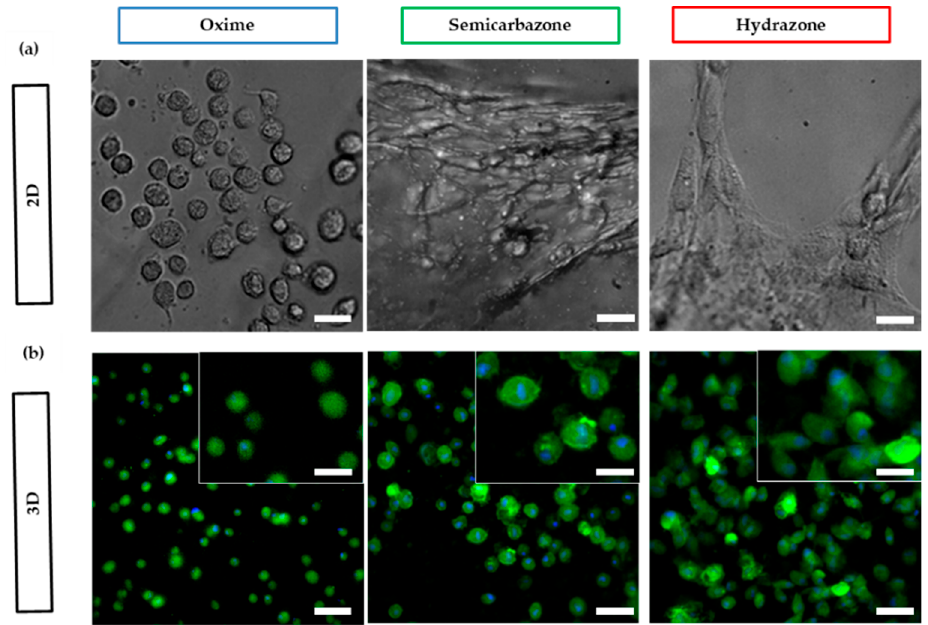
Figure 4. Cell viability: ( a ) Image showing live cells (in green) after seven days of encapsulation in gels indicating that great majority of cells are live and gels did not cause cytotoxicity, Scale bar: 200 µm and 25 µm for inset images. ( b ) Cell metabolic activity recorded after 12, 24, 96, and 168 hours. For “cell aggr” condition, cells were cultured in pellets, a standard for chondrocyte cell culture. The values reported are an average of n = 3, ± standard deviation.